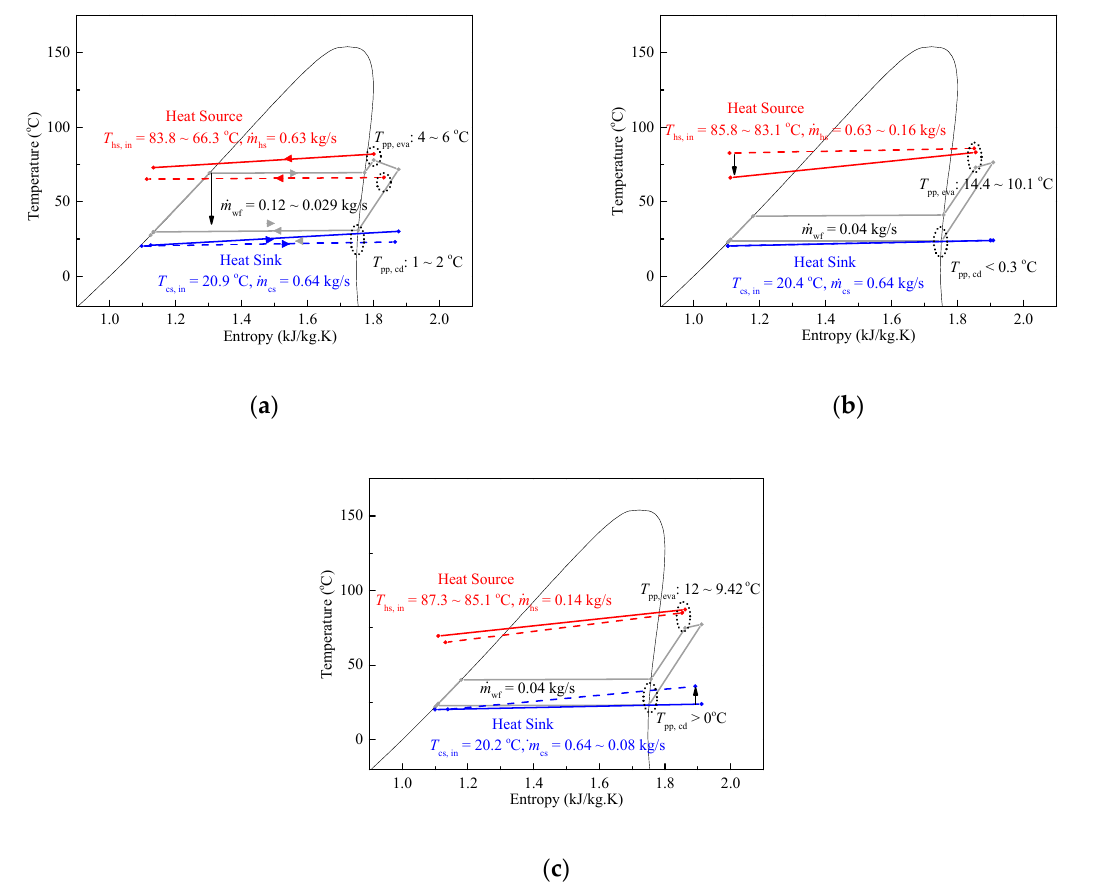
Figure 10. T-s diagrams for downward step change with a constant mass flow rate: ( a ) changes in m wf ; ( b ) changes in m hs ; ( c ) changes in m cs .